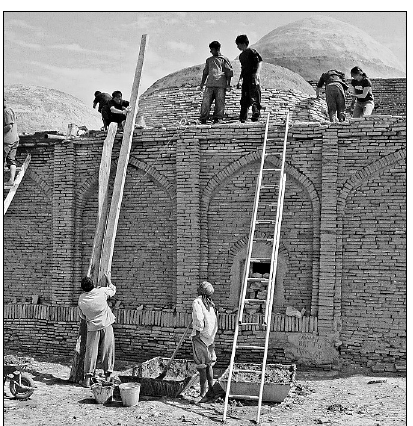
Figure 5 Repairing the roof of the mau- soleum of Mohammed Ibn Zayd, a